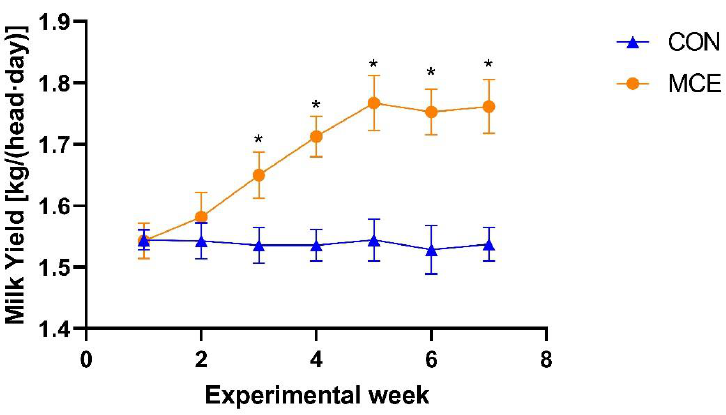
Figure 1. Change in average milk yield throughout the study period in dairy goats. CON—fed a basal diet, MCE—fed a basal diet supplemented with 400 mg/kg macleaya cordata extract. Bars indicate the standard errors. * Superscripts indicate significant difference ( p < 0.05), while no-sign superscripts indicate no significant difference ( p >